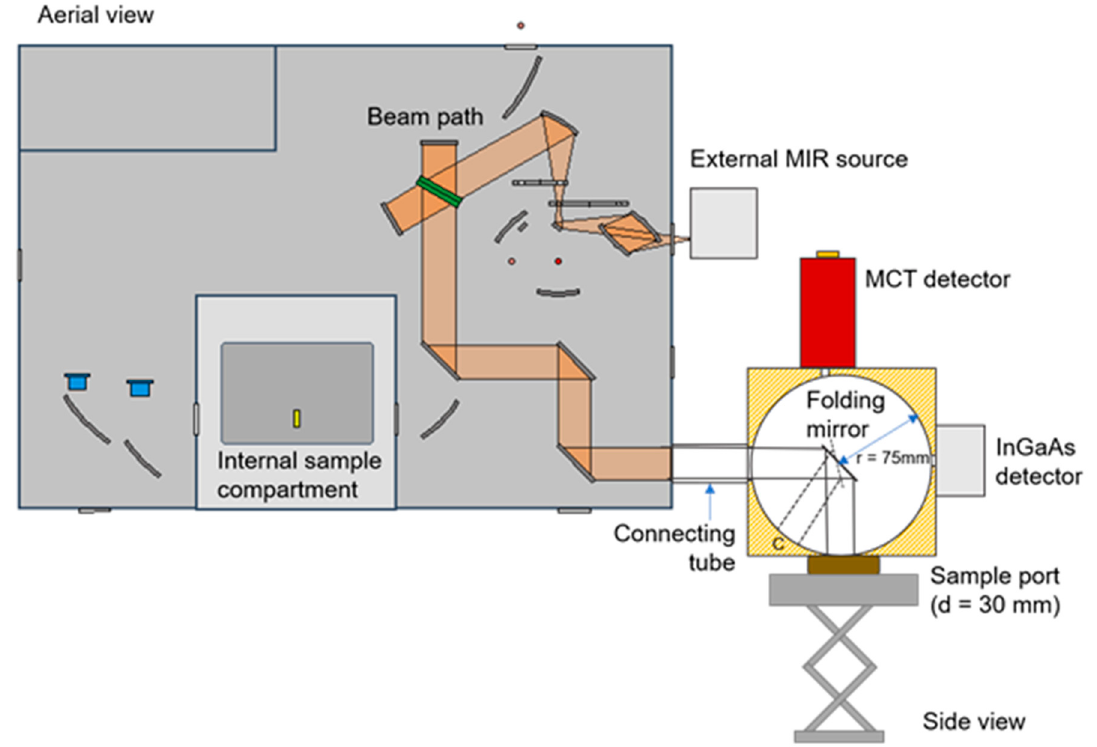
Figure A2. A sketch of the instrument setup at King’s as it was used for this study, with the external MIR source deployed.